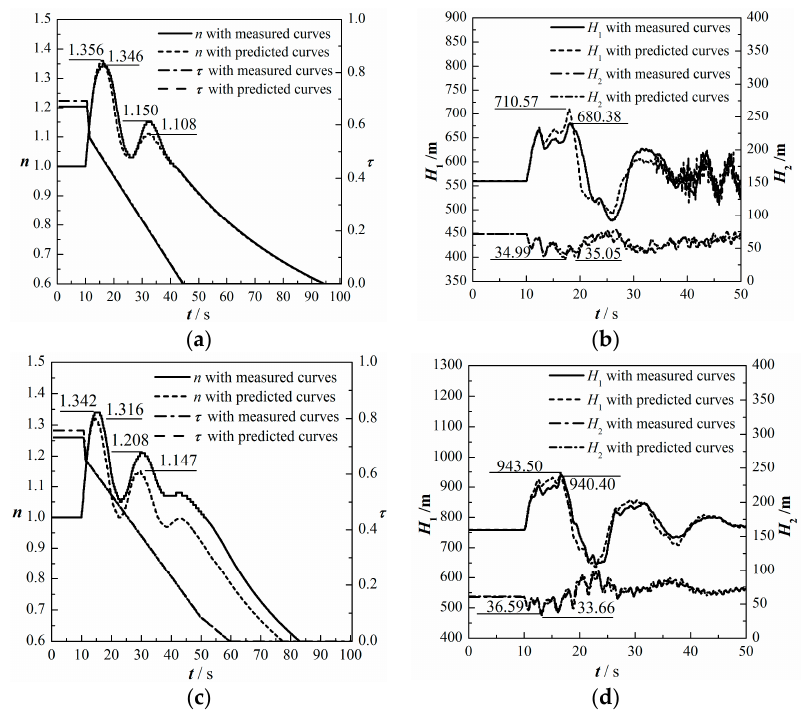
Figure 12. Simulation results of simultaneous load rejection using the predicted characteristics and the measured characteristics. ( a ) rotational speed of the Xianju pump-turbine; ( b ) pressure at the spiral case inlet and the draft tube inlet of the Xianju PSPP; ( c ) rotational speed of the Xilongchi pump-turbine; ( d ) pressure at the spiral case inlet and the draft tube inlet of the Xilongchi PSPP.